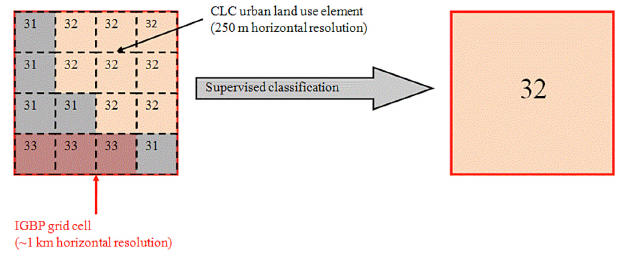
Fig. 3. Supervised classification and aggregation of the 250m spa- tial resolution CLC urban land use elements to the 30arcsec spatial resolution IGBP land use